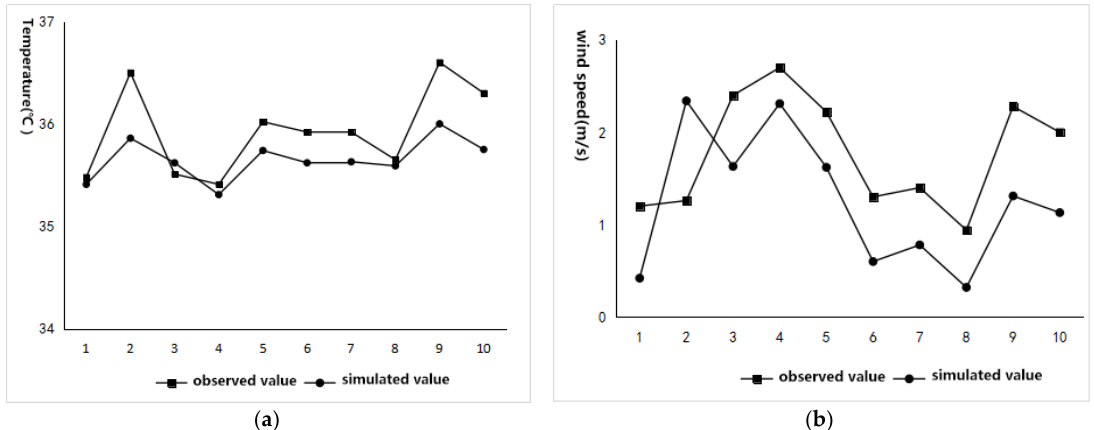
Figure 4. Comparison between measured values and simulated values for verifying the validity of Envi-met software. ( a ) Air temperature values; ( b ) wind speed values.